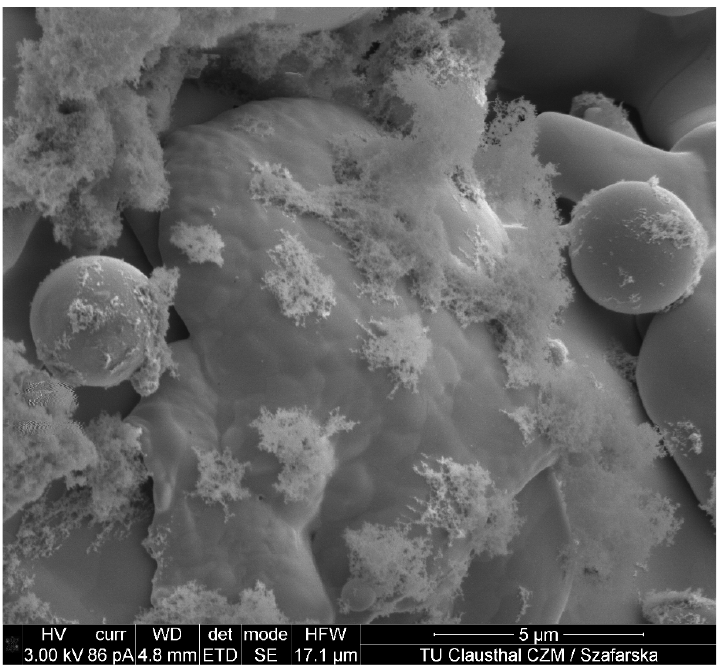
Figure 16. SEM micrograph of a copper coating surface with undeformed microparticles and fine SiO 2 agglomerates.